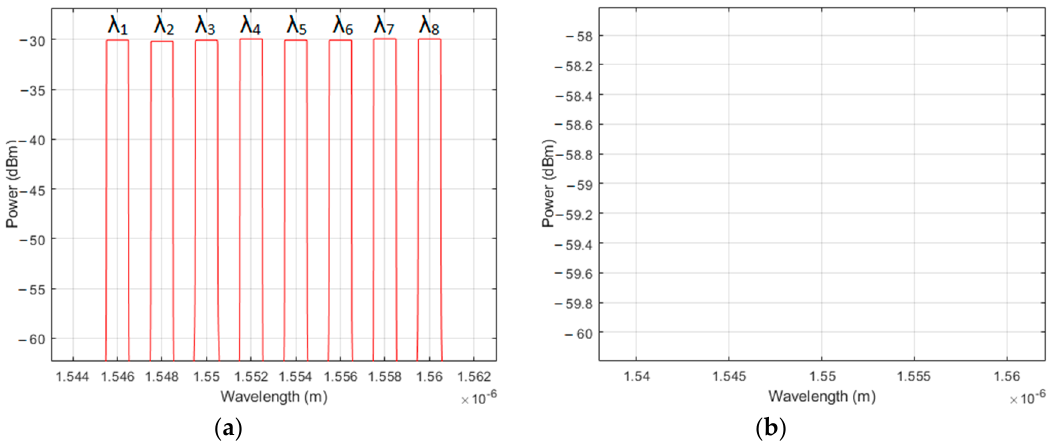
vertical polarization.